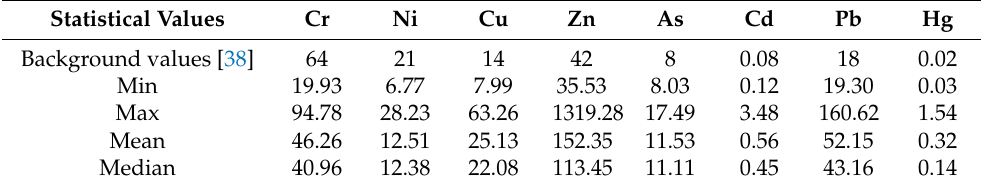
Table 2. Heavy metal statistical values in